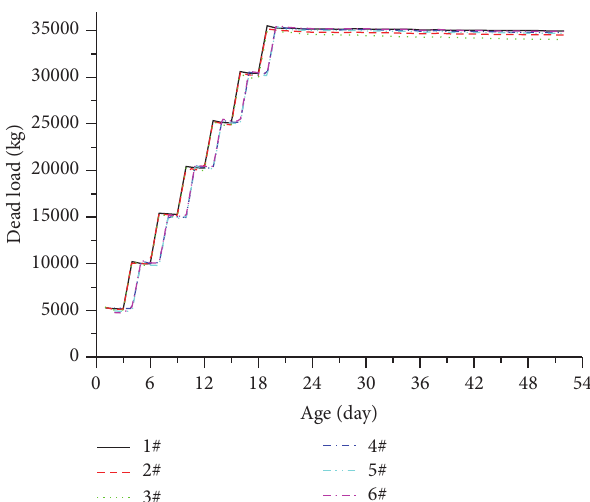
Figure 9: The dead load applied at related time.